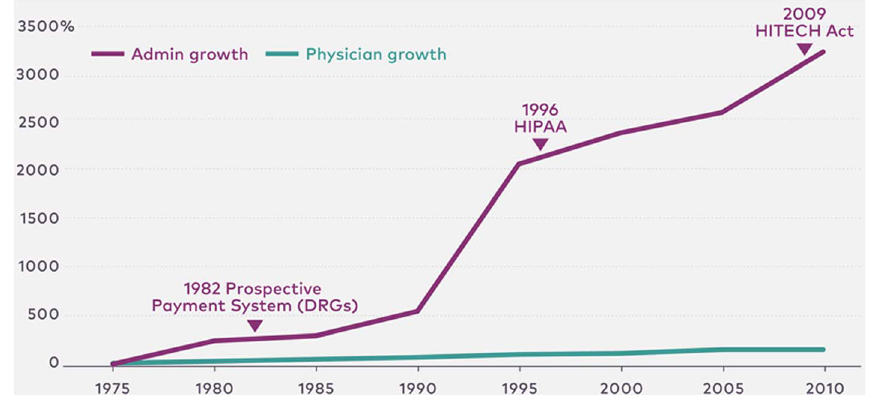
Figure 1. Healthcare administrator ’ s growth in the US. Healthcare administrator ’ s growth by 3200% between 1975 and 2010 compared to 150% Physician growth according to Athena Health analysis of data from Bureau of Labor Statistics, the National Center of Health Statistics, and the United States Census Bureau ’ s Current Population survey in accordance to [26]. Admin: administration; HIPAA: Health Insurance Portability and Accountability Act; HITECH Act: Health Information Technology for Economic and Clinical Health Act; DRGs: diagnosis-related group ’ s.